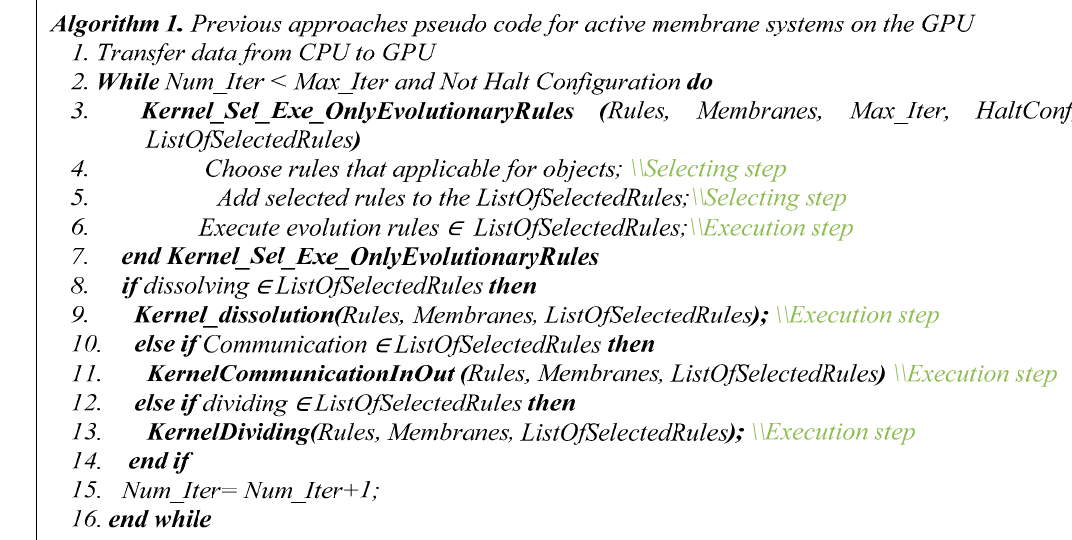
Figure 3. Algorithm 1 for active membrane systems on the GPU [31–33].